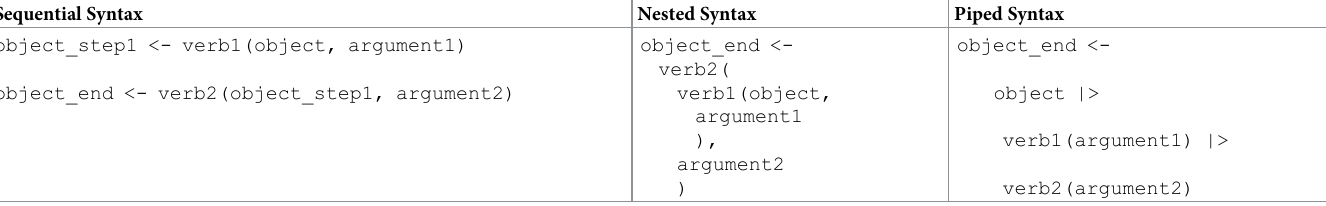
Table 1. Examples of 3 styles of code, each changing an object (such as a data frame or a vector), using 2 verbs (functions that manipulate that object), and 2 argu- ments specifying those verbs (such as applying that function to only section X of the object). If these look unintelligible to you, that’s okay! They are only meant to show that in R, there are different syntax strategies to complete the same tasks. If one looks more interpretable than the others, then great—you have found your